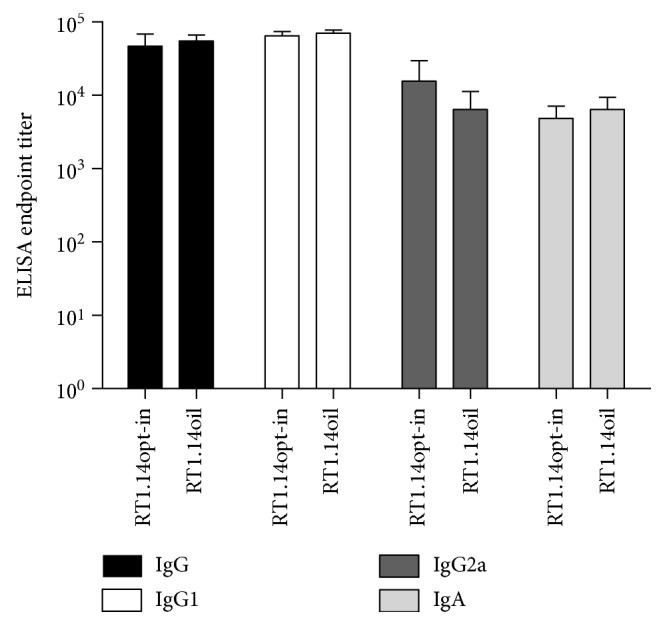
RT-specific IgGs and IgA induced in sera of mice immunized with pVaxRT1.14opt-in and pVaxRT1.14oil plasmids. Endpoint titers of RT-specific total IgG, IgG subtypes (IgG1, IgG2a), and IgA antibodies detected in the sera of BALB/c mice immunized with the genes encoding RT1.14opt-in and RT1.14oil plasmids. Data represent a mean + SD for the endpoint titer of antibodies against recombinant RT1.14 protein for four mice per group in two independent immunization runs. Cutoffs were set against the control mice immunized with empty vector pVax1 (see “Materials and Methods”). Groups demonstrate no significant difference in either IgG, or IgG1, or IgG2a, or IgA levels (p > 0,05).